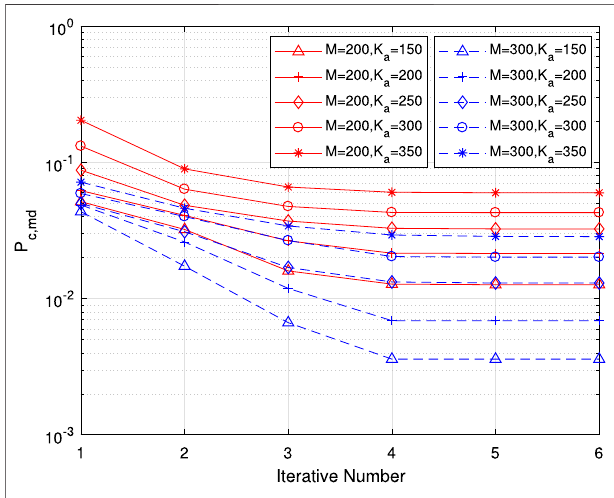
FIGURE 11 | Per-user error probability of misdetection for common information as a function of the iterative number for various numbers of antennas and active users.